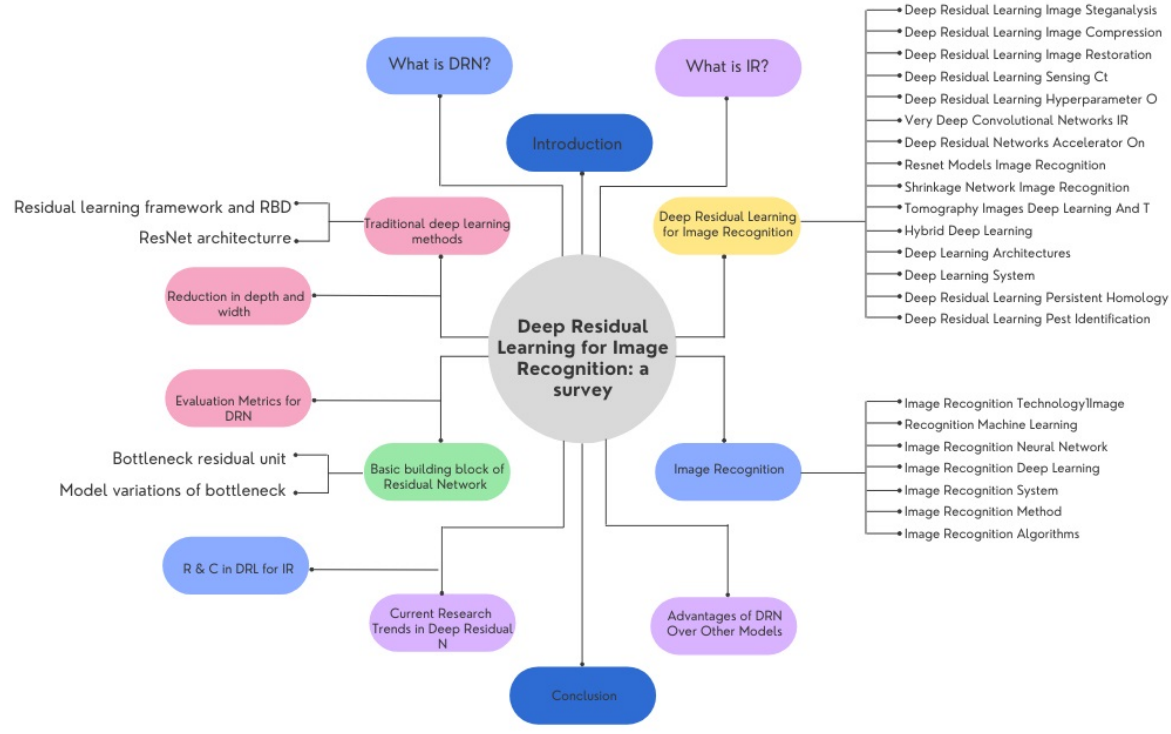
Figure 1. Detailed Flowchart.